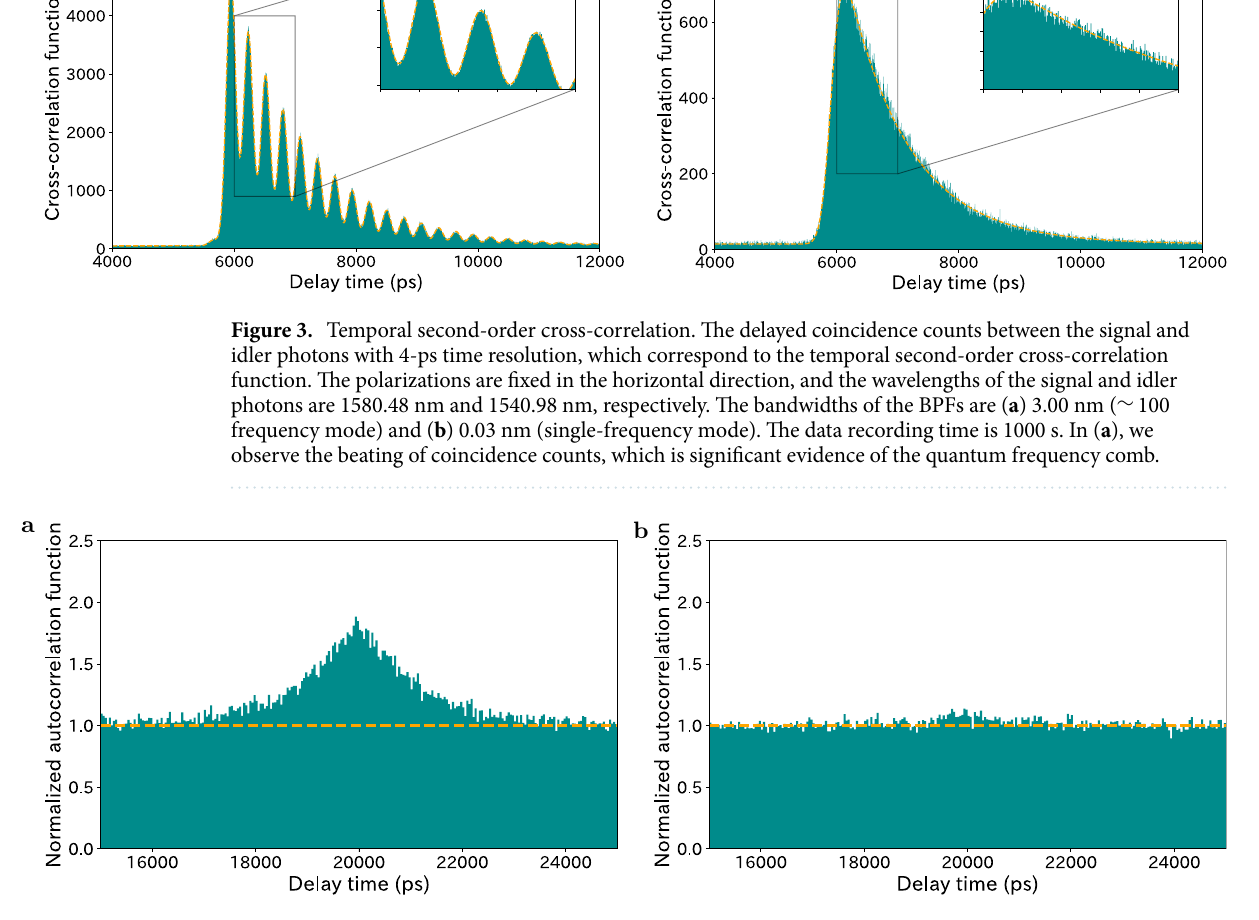
Figure 4. Temporal second-order autocorrelation. The delayed coincidence counts between idler photons with 40-ps time resolution; this corresponds to the temporal second-order autocorrelation function. The polarizations are fixed in the horizontal direction. The central wavelength and bandwidth of the BPFs are respectively set to ( a ) 1543.76 nm and 0.03 nm and ( b ) 1543.89 nm and 0.30 nm. The data recording time is 1000 s. The orange lines represent the normalization factors estimated from the coincidence counts with a large delay. In ( a ), the bunching effect appears at the zero delay because unheralded photons behave like thermal light in the single-frequency mode. However, in ( b ), it is suppressed by the interference in multiple frequency